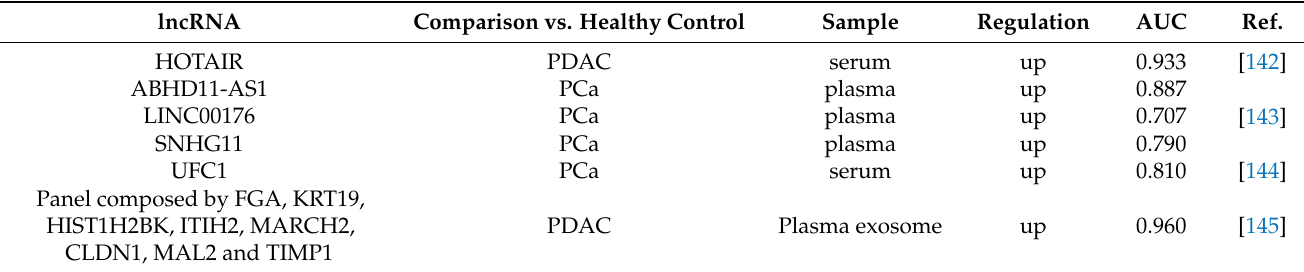
Table 2. Summary of promising long non-coding RNAs for diagnosis of PCa. lncRNA Comparison vs. Healthy